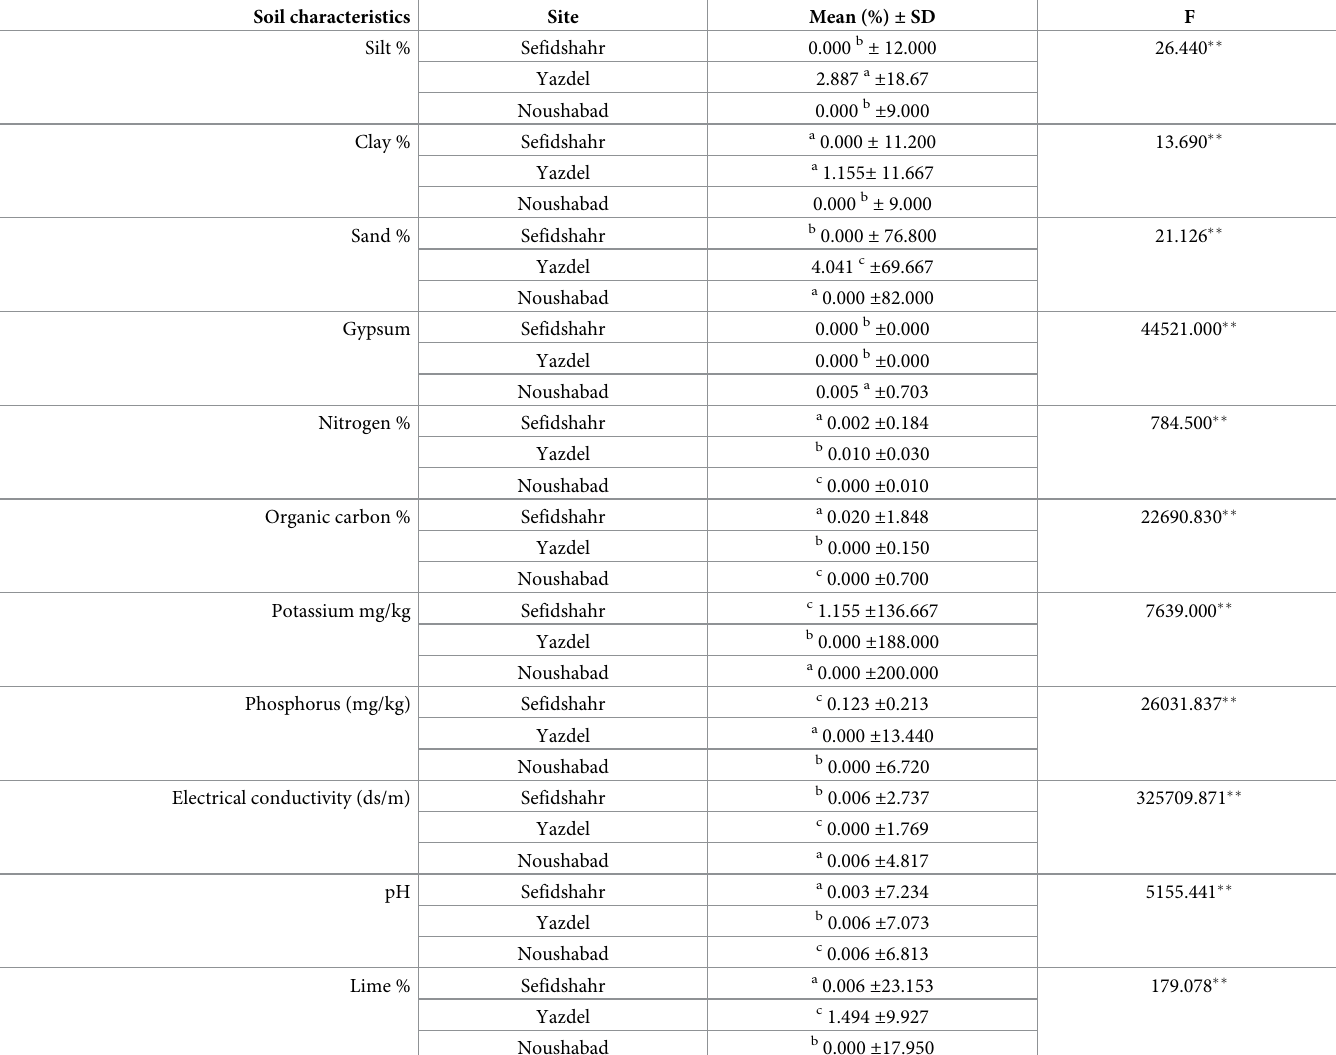
Table 6. Comparison of the means of soil characteristics of crop